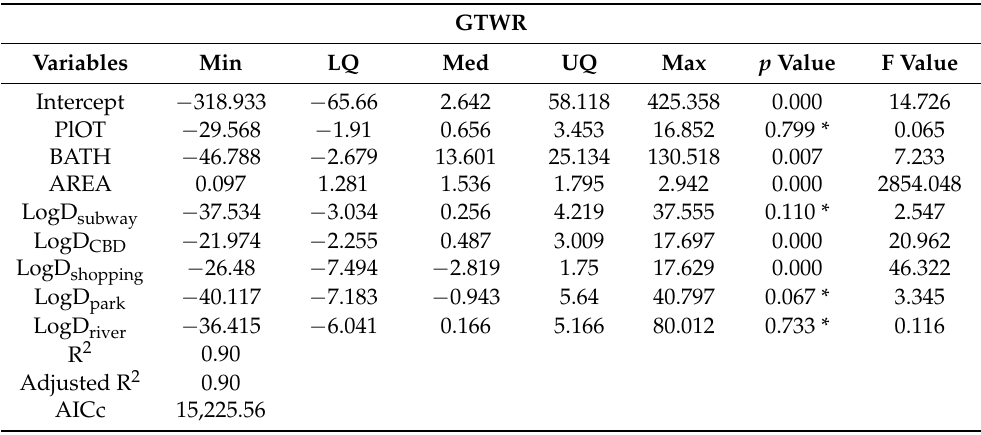
Table 6. The distribution of the localized coefficient estimates for the GTWR model (B = 2221 and τ = 80,118).